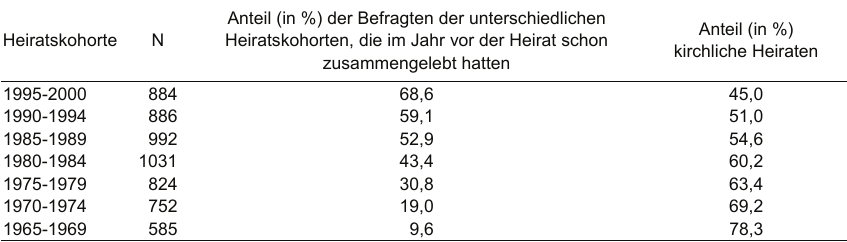
Tab. A 2: Voreheliche Kohabitation und kirchliche Heiraten nach